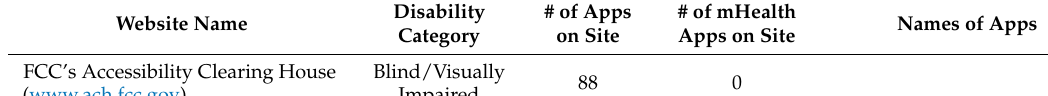
Table 2. mHealth apps available on resources websites for people with